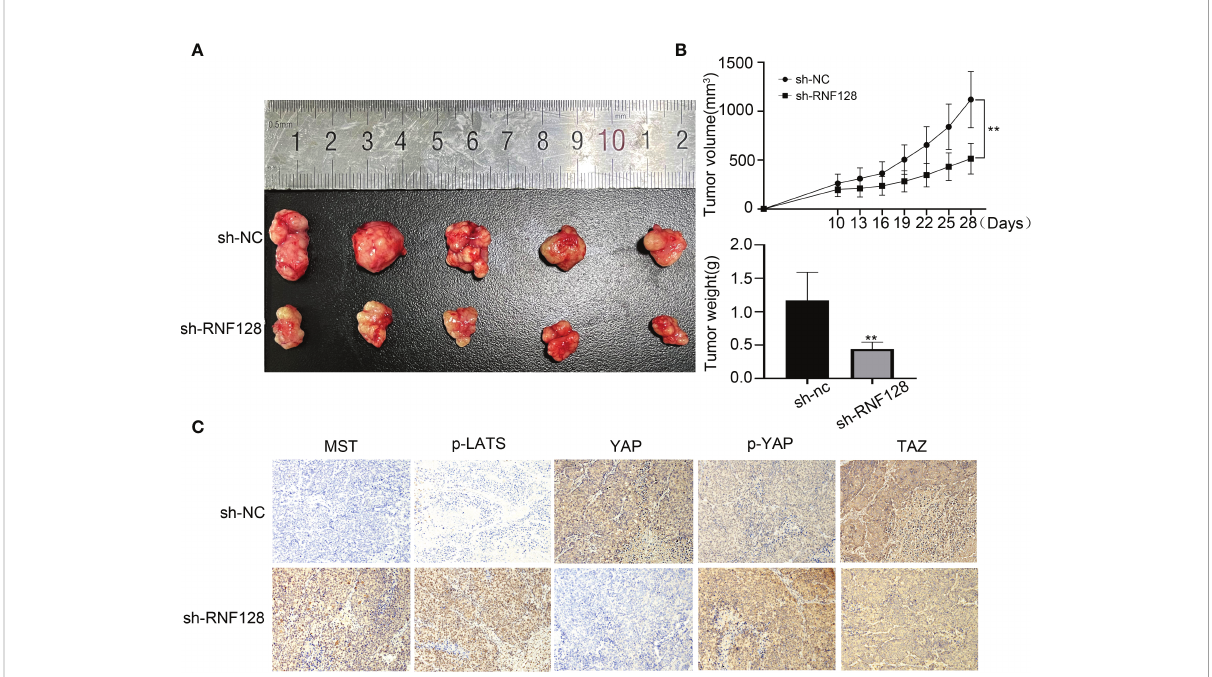
FIGURE 6 RNF128 promotes colorectal cancer progression in nude mice. (A, B) Tumors derived from nude mice injected with shNC and shRNF128 LoVo cells (n=5 per group). Tumor growth curves were generated, and tumor weight was measured. ** P <0.001. (C) IHC analysis was used to assess the expression of Hippo pathway components in